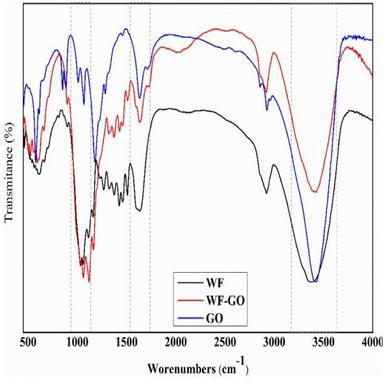
Infrared Spectra of the WF, GO and WF-GO hybrid.